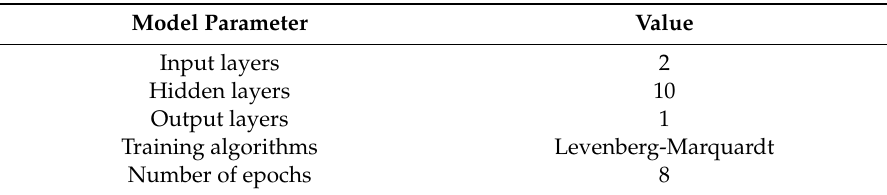
Figure 8. Sensitivity analysis for the numbers of hidden layers used in the ANN models. Table 4. Model 2 ANN model parameters.